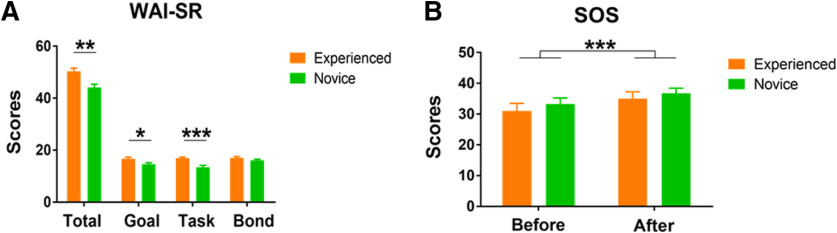
Behavioral results. A, The total and individual dimension scores for the WAI-SR in the two groups. B, The total scores of the SOS-10 before and after 40-min psychological counseling sessions in the two groups; *p < 0.05, **p < 0.01, ***p < 0.001. Error bars indicate SEs.